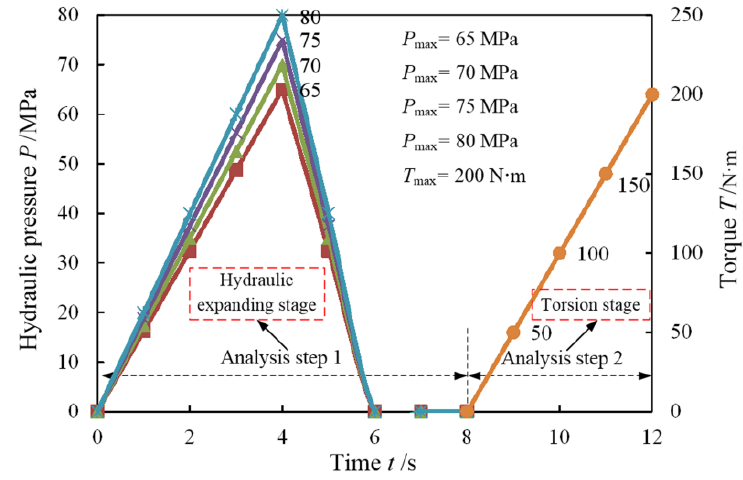
Figure 7. The loading curves adopted in this finite element simulation.